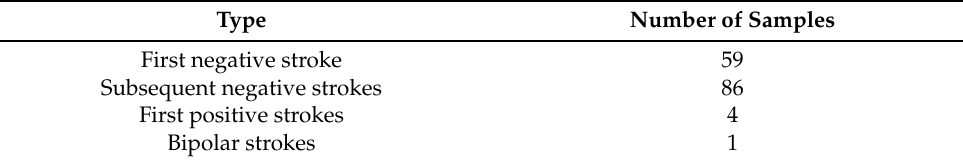
Table 3. Observed lightning